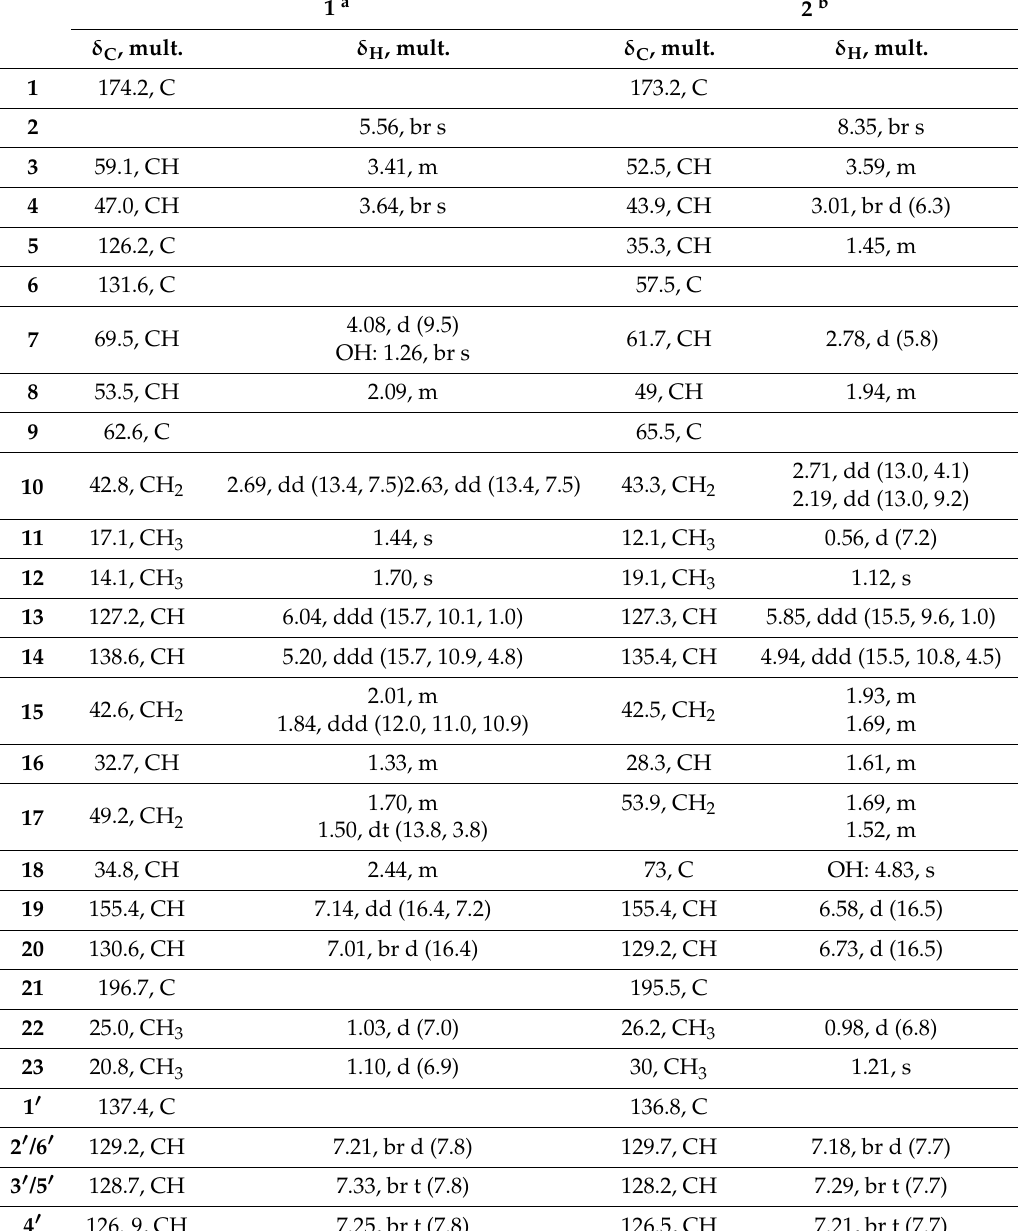
Table 1. Nuclear magnetic resonance (NMR) spectroscopic data for fragiformins C ( 1 ) and D ( 2 ). 1 a 2 b δ C , mult. δ H , mult. δ C , mult. δ H , mult.